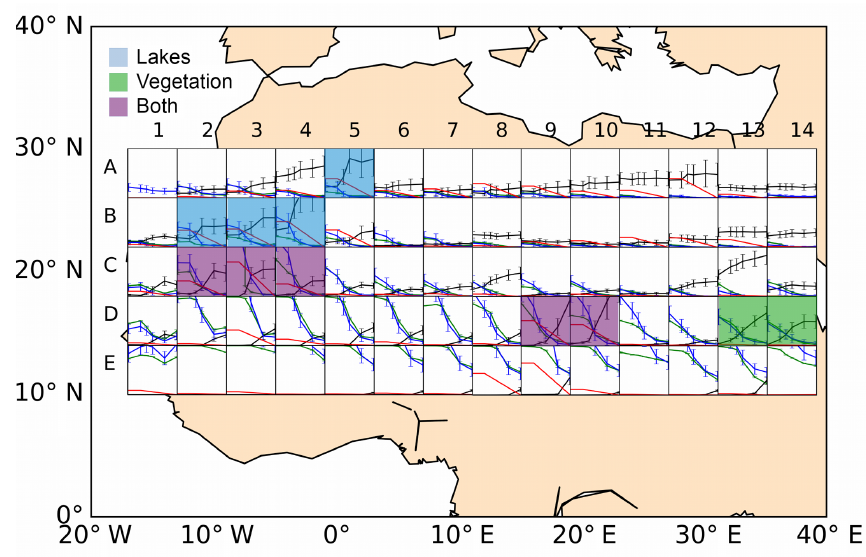
Figure 9. Dust emissions (black), vegetation cover fraction (green), lake cover fraction (red) and precipitation (blue) in boxes of 2 × 2 grid cells in North Africa (17 ◦ W–39 ◦ E, 10–30 ◦ N). The scales are similar to those in Fig. 8. The boxes in which strong changes in dust emissions coincide with strong changes in lake level (blue), vegetation cover (green) or both (purple) are marked.